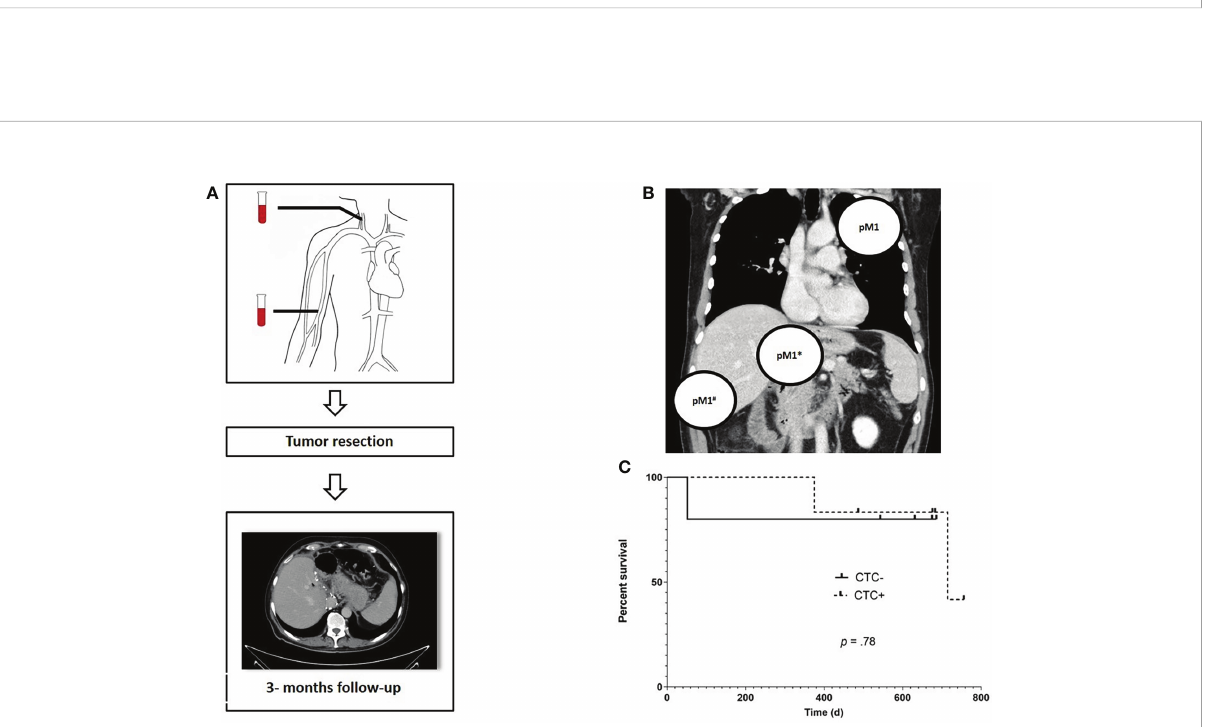
FIGURE 3 Study algorithm, localization of prior occult metastases and overall survival (OS) for FC patients. Prior to surgery, blood samples for CTC measurement were obtained from the central and peripheral venous compartment. Following tumor resection, a CT scan was scheduled every three months for routine followup (A) . Localization of metastases that were not detectable at the initial radiology staging but were found during or immediately after tumor resection, e.g. pulmonary fi liae (pM1), a distant metastasis in fi ltrating the duodenum (pM1*) and local peritoneal carcinomatosis (pM1#) in a total of three CTC + patients (B) . Kaplan – Meier estimates reveals no signi fi cant difference in terms of OS between CTC positive and negative RC patients (HR: 0.74; 95% CI:.04- 12.28 (C)